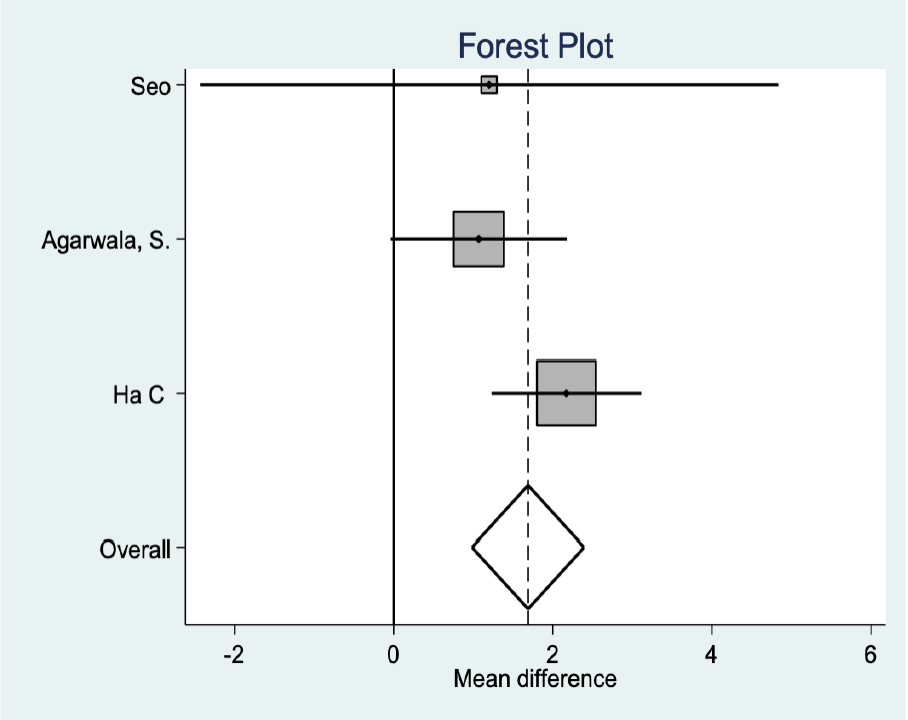
Figure 5. Feller score data.